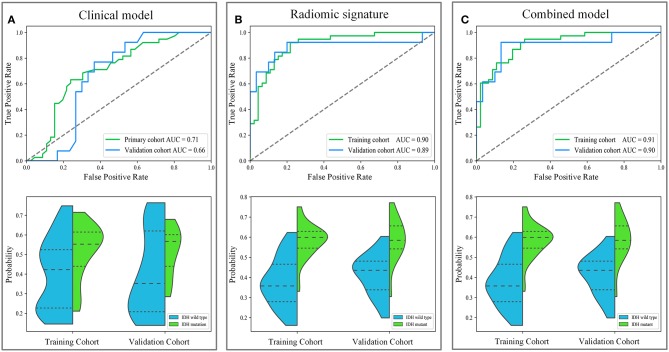
The diagnostic performance of these different models in predicting IDH genotype. The first row depicts the receiver operating characteristic (ROC) curves of the three models. The second row depicts the distribution of the IDH mutant probabilities predicted by the three models, where the horizontal dash lines are the quartiles. Subgraph (A–C) show the performance of clinical model, radiomic signature and combined model to predict IDH genotype, respectively.